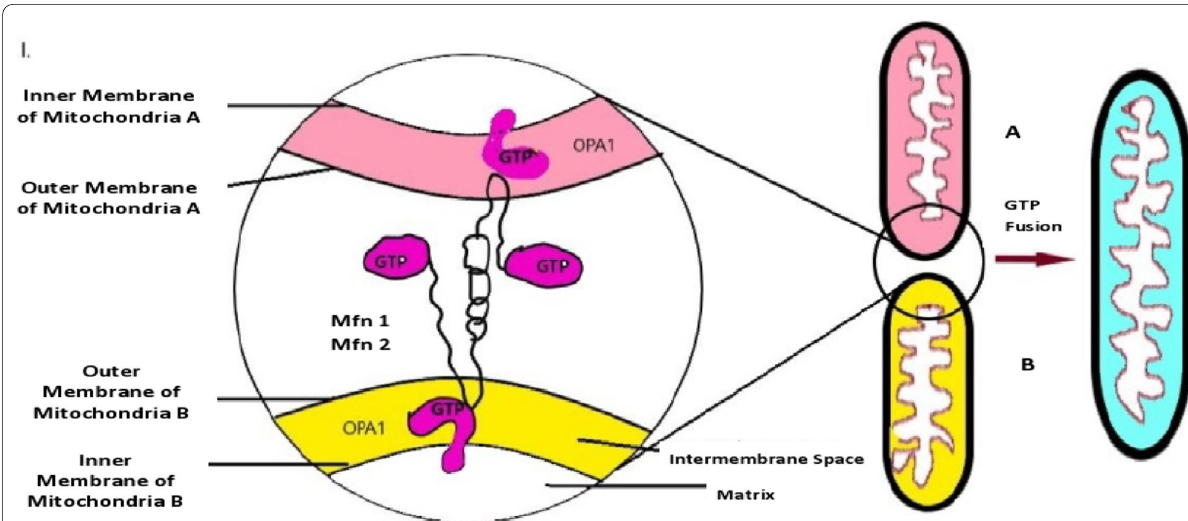
Fig. 5 Mitochondrial fusion demonstrating linking of membranes and compartments to produce a single larger mitochondrion. GTP: Guanosine-5 ′ -triphosphate; OPA: Optic atrophy 1; Mfn: mitofusin; GDP: Guanosine